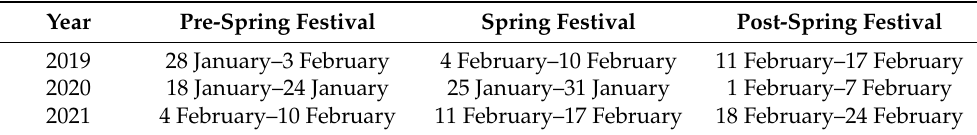
Table 5. Study period for spring festival during different